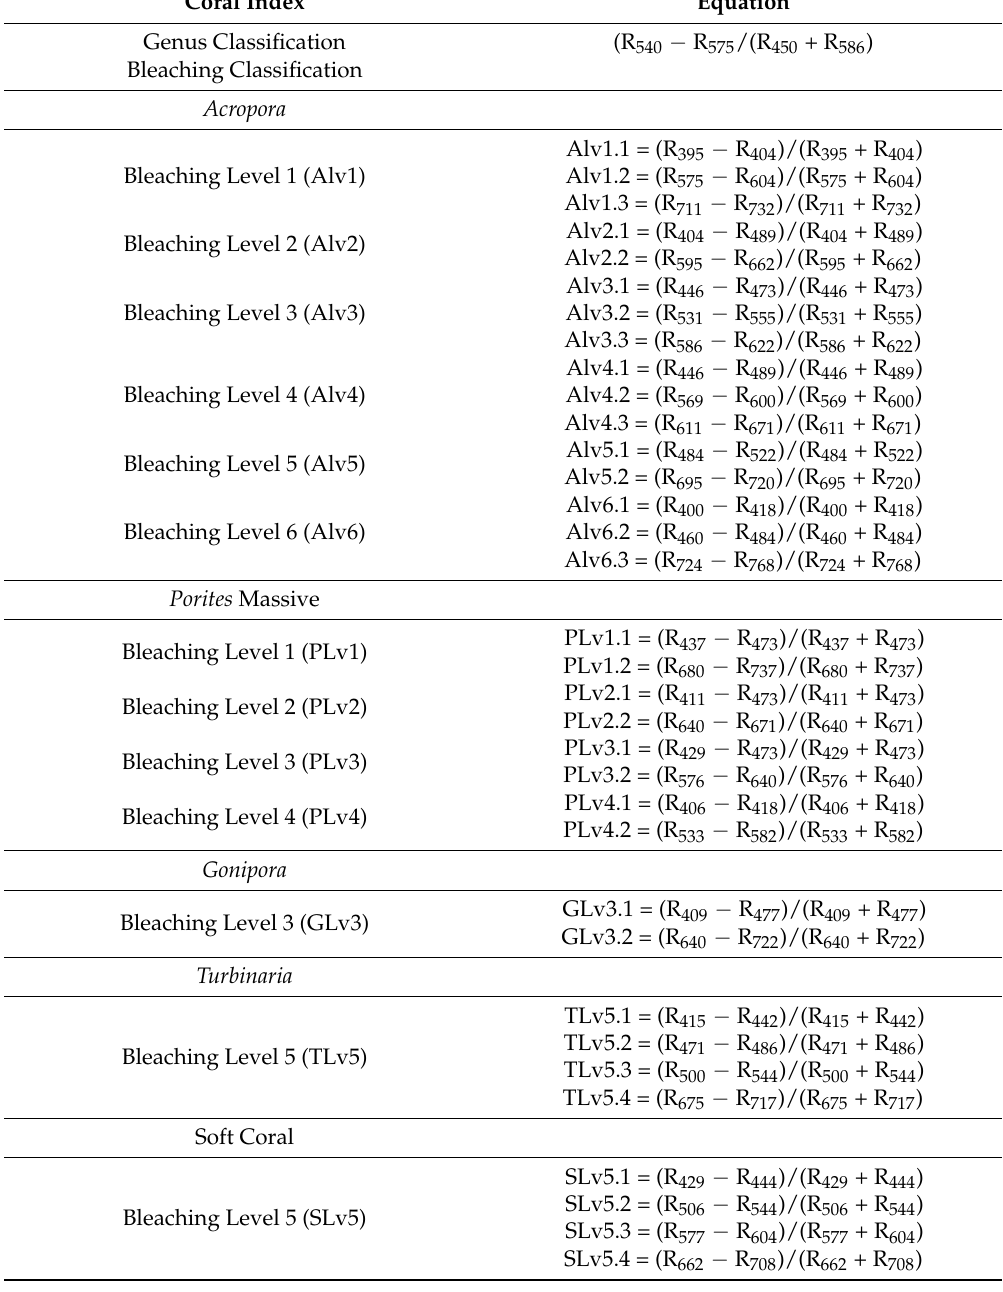
Table 1. Coral bleaching indices used in the analysis of reef type and